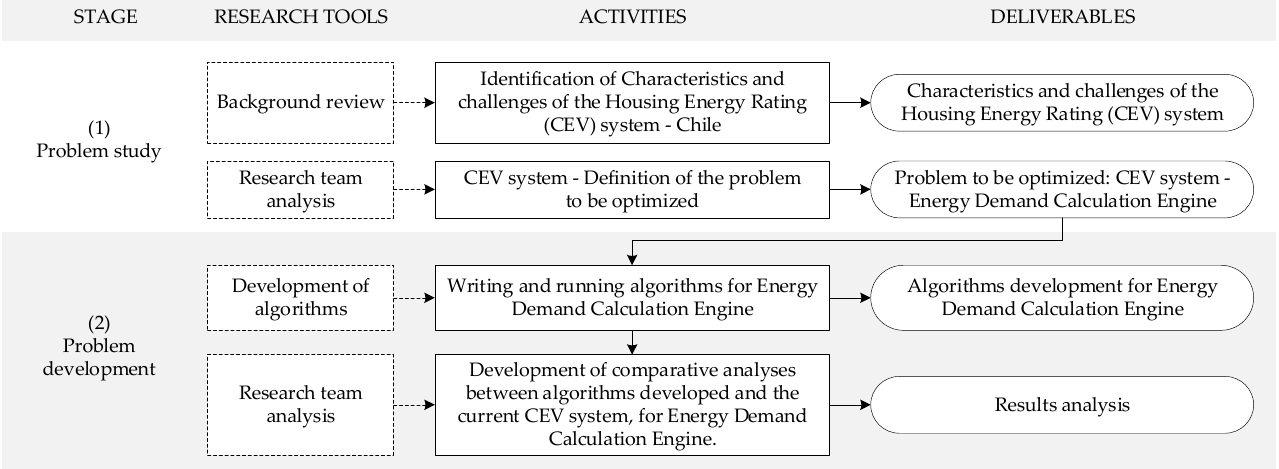
Figure 1. Research method.